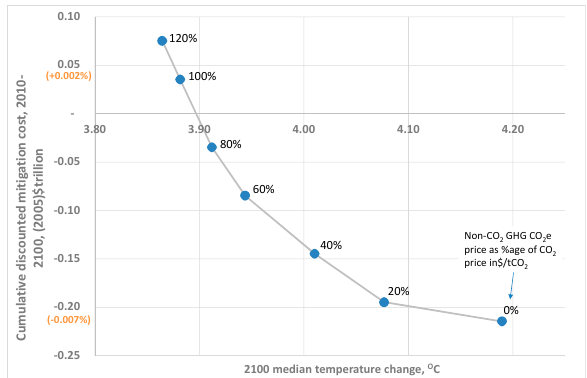
Figure 9. Cost of meeting 2100 temperature change levels with non-CO 2 GHG mitigation at a range of CO 2 e prices relative to CO 2 mitigation, 4 °C scenario with delayed action to 2020. Notes: Figures in parenthesis on Y-axis show costs as a share of total cumulative 2000–2100 discounted GDP (at 5% per year discount rate).